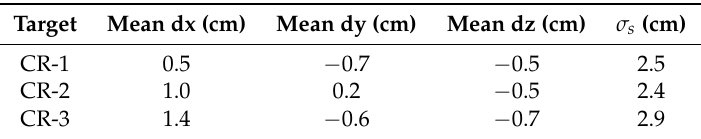
Table 2. Geometric accuracy for DLR’s three remote controlled corner reflectors (CR) for each dimension (x, y, z) and the absolute position error σ s